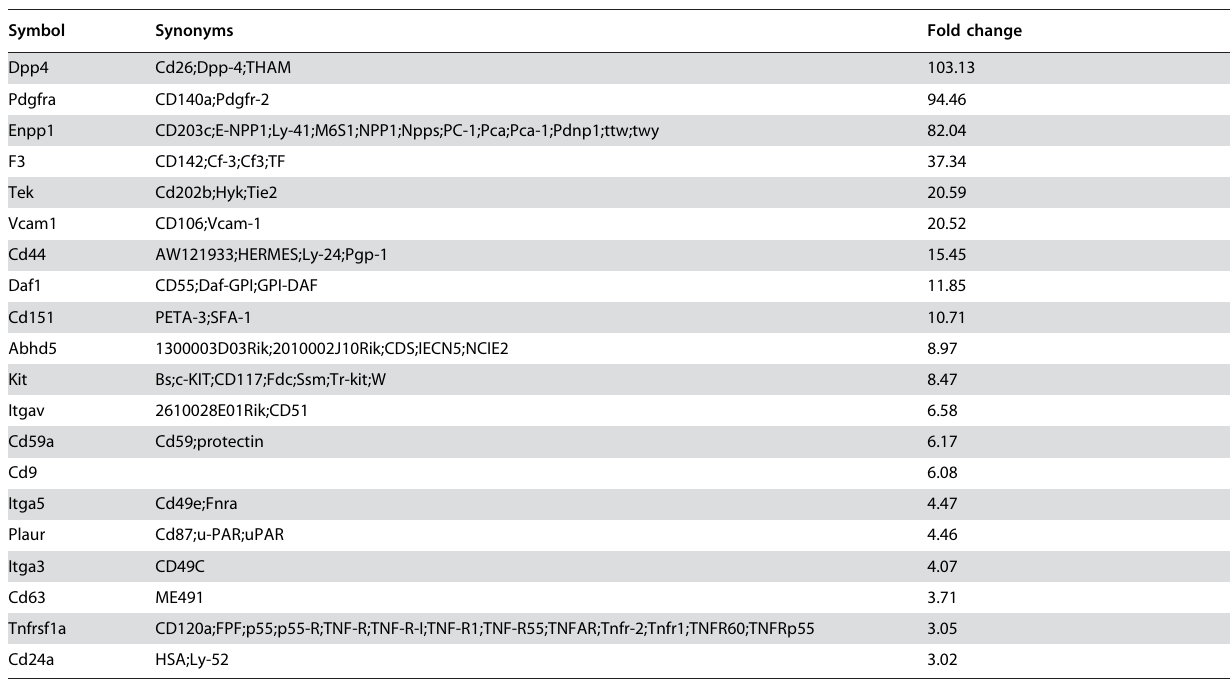
Table 1. List of top 20 highly expressed genes encoding CD antigens generated by comparing gene expression profiles of